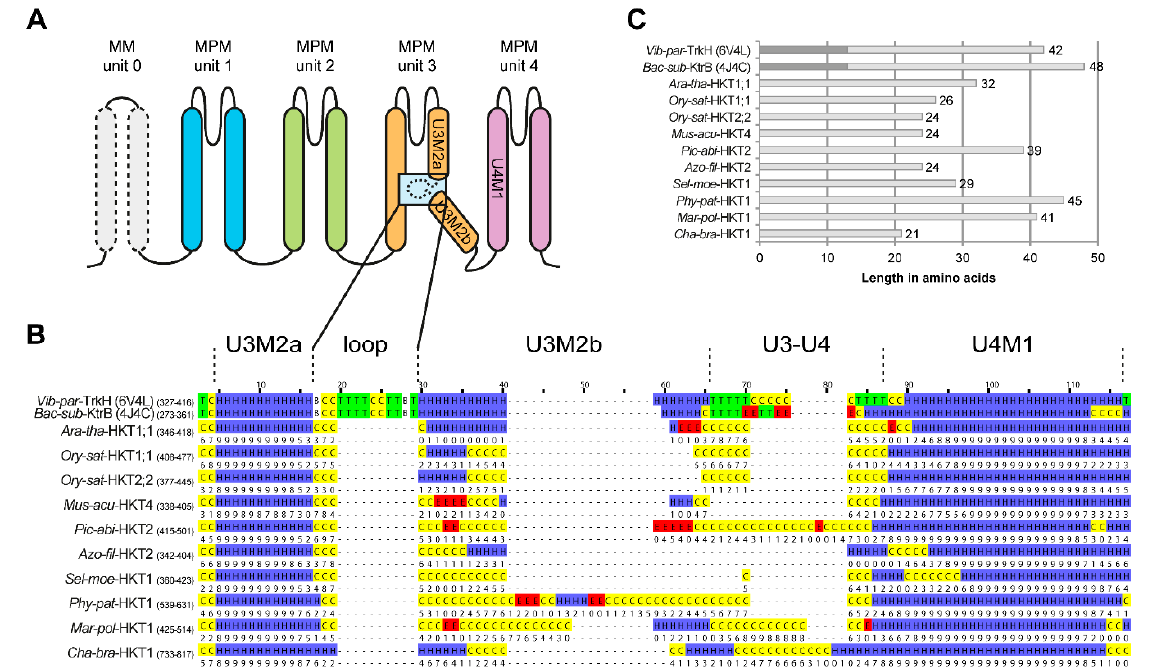
Figure 4. Secondary structure of the second transmembrane spanning segment of the third unit. Secondary structure analysis of the following sequences that represent each phylogenetic group. Sequences were aligned with MUSCLE [54]. Used sequences in this analysis: Ara-tha-HKT1;1 ( Arabidopsis thaliana , AT4G10310), Ory-sat-HKT1;1 y Ory-sat-HKT2;2 ( Oryza sativa , Os04g51820 y Q93XI5), Mus-acu-HKT4 ( Musa acuminate , GSMUA_Achr1T23660_001), Pic-abi-HKT2 ( Picea abies , MA_54668g0010), Azo-fil-HKT2 ( Azolla filiculoides , Azfi_s0027.g023651), Sel-moe-HKT1 ( Selaginella moellendorffii , PACid_15414191), Phy-pat-HKT1 ( Physcomitrella patens , Pp3c1_15810V3), Mar-pol-HKT1 ( Marchantia polymorpha , Mapoly0009s0076) and Cha-bra-HKT1 ( Chara braunii , g19013). Additionally, sequences of Vibrio parahaemolyticus (Vib-par-TrkH) and Bacillus subtilis (Bac-sub-KtrB) are included for reference. ( A ) Schematic representation of the Trk/Ktr/HKT family protein structure. Structures in dashed lines (unit 0 and the internal loop in unit 3) are only present in some members of the family. Unit 0 is found in bacterial Trk channels only, and the internal loop is found in Trk and Ktr channels but not in plant HKT. ( B ) The secondary structure was determined with Porter5.0 that was recently tested among the best performing secondary prediction programs [55,56]. Prediction is based on three classes, which correspond to helix structures represented by H in blue (DSSP classes H, G, I), to strand structures represented by E in red (DSSP classes E, B), and to coil and turn structures represented by C in yellow (DSSP classes S, T.). Limits for transmembrane domains, loop and turn are approximated based on the secondary structure of TrkH and KtrB extracted from the respective crystal structures (TrkH: 6V4L, KtrB: 4J7C) using the visualization software VMD [57]. The secondary structure corresponds to the DSSP classes and colour code as described above with turns (T) coloured in green and isolated bridges (B) in white. Below each prediction is the confidence score for the prediction ranging from 0 (lowest confidence) to 9 (highest confidence). ( C ) Illustration of the sequence length between the end of the first half of the second transmembrane domain of unit 3 (U3M2a) and the beginning of the first transmembrane domain of unit 4 (U4M1). The length of the internal loop in TrkH and KtrB is marked in darker grey. Numbers next to the bars indicate the absolute length of sequence between the indicated transmembrane